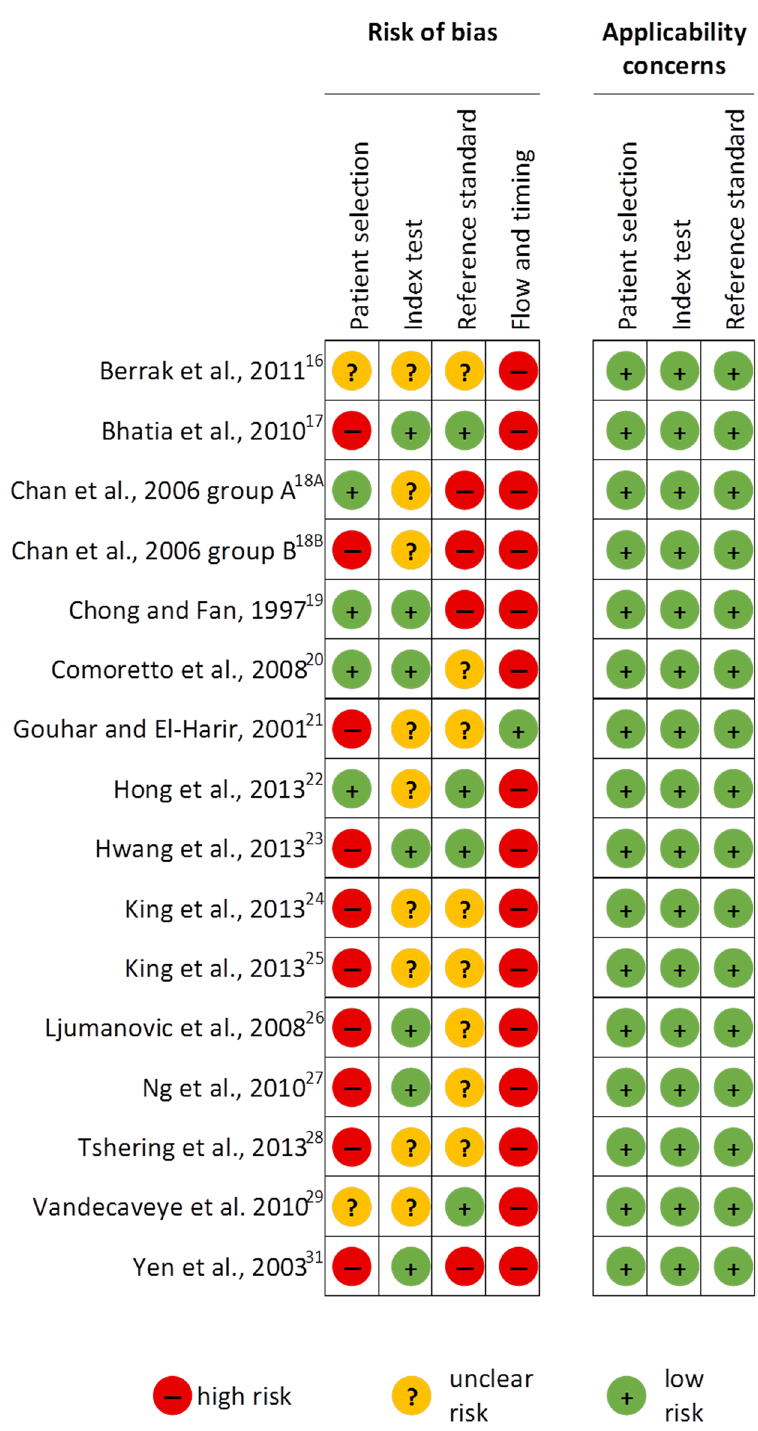
Fig 2. Risk of bias and applicability concerns summarywith for each domain of the QUADAS-2 for each included study.